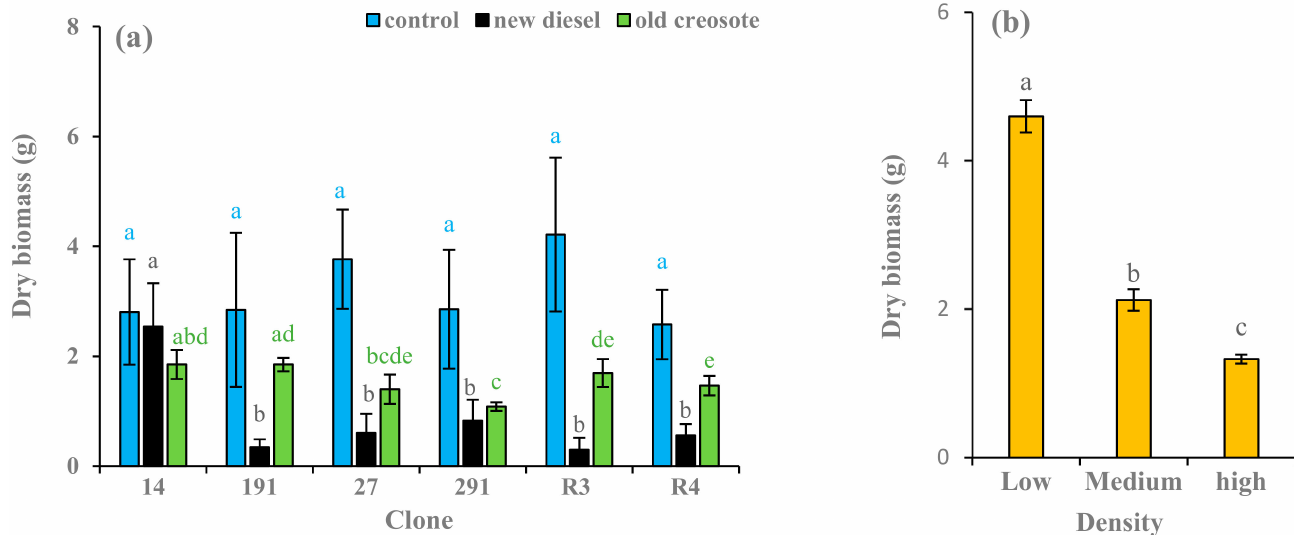
Figure 5. Average ( n = 3) dry biomass of stem (g) of European aspen and hybrid aspen clones grown in different soil treatments ( a ) and plant densities ( b ). Error bar indicates ± standard error (SE). Means between clones followed by the same lower-case letters with the same font color are not significantly different ( p > 0.05). Means between density treatments followed by the same lower-case letters are also not significantly different ( p >